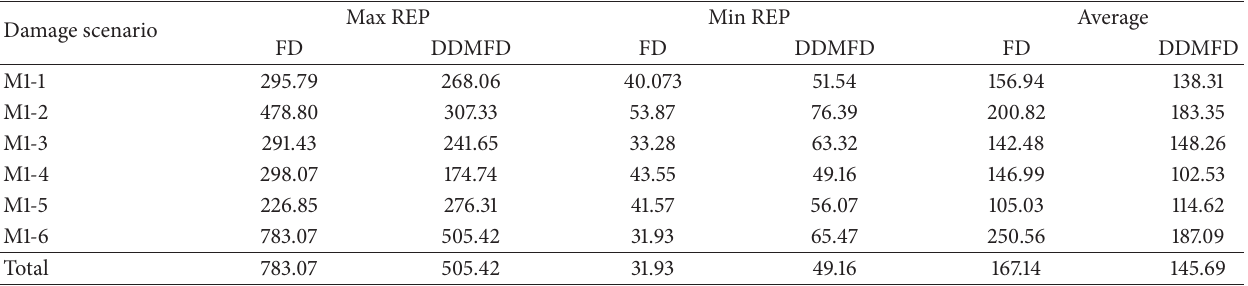
Table 11: REP ranges in different adj,adm